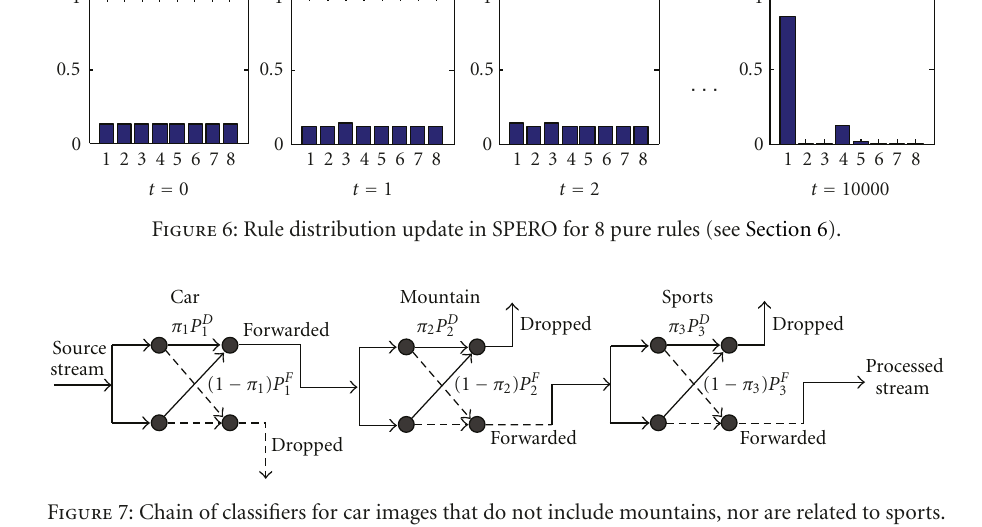
Figure 7: Chain of classifiers for car images that do not include mountains, nor are related to sports.